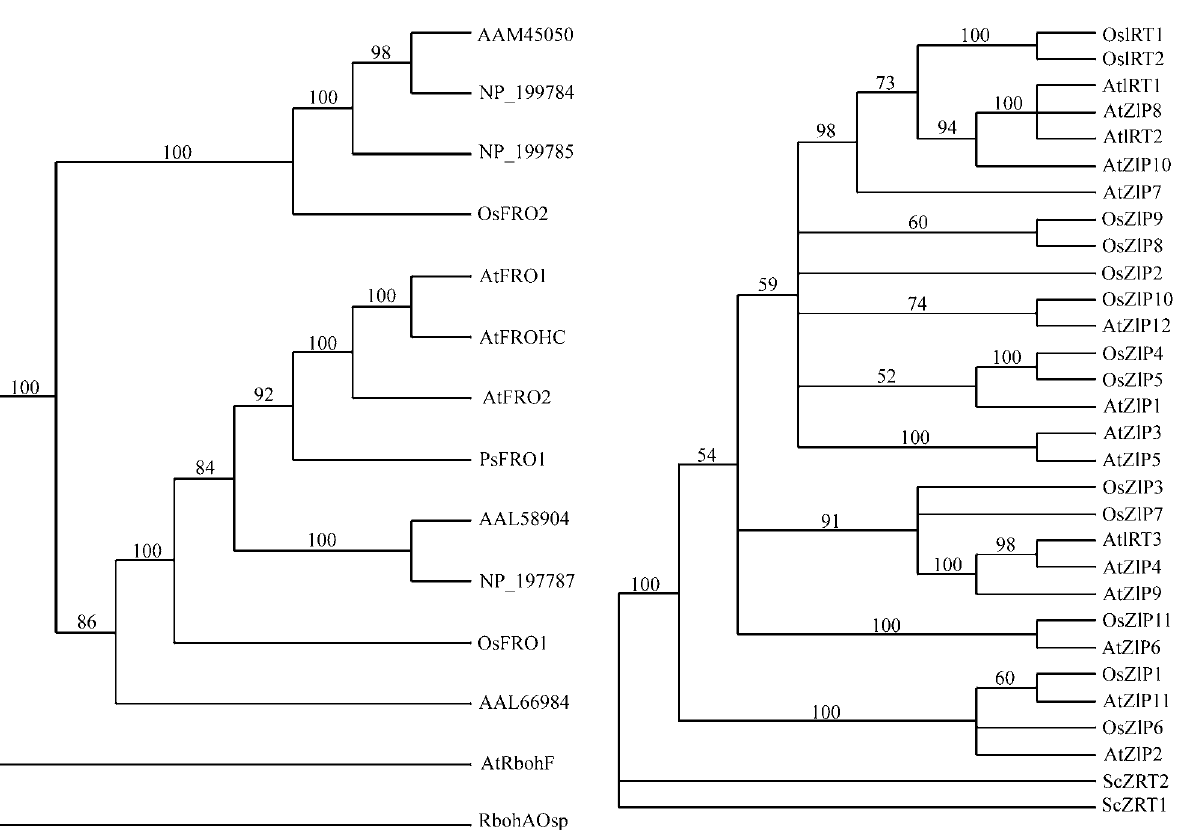
Figure 4 - Phylogenic analysis of the FRO protein family. Accession numbers of nucleotide sequences and corresponding predicted OsFRO proteins are shown in Table 2. Accession numbers to the other proteins are as follows: AtFRO1: CAA70769; AtFRO2: CAA70770; AtFrohC: AAB72168; PsFRO1: AAK95654; AtRbohF ( Arabidopsis thaliana Re- spiratory burst oxidase F): BAA28953; RbohAOsp ( Oryza sativa respira- tory burst oxidase A): AAB87790. The six additional Arabidopsis paralogs are discriminated in the dendrogram with the respective acces- sion numbers.